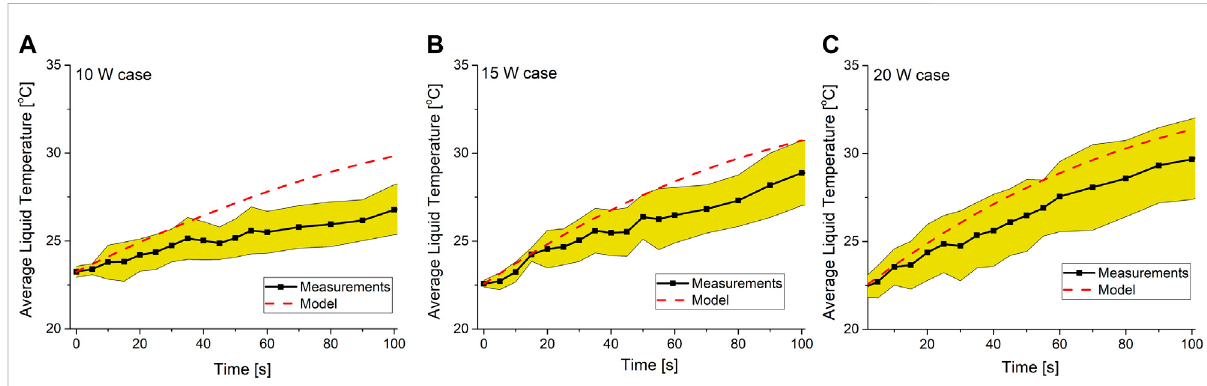
FIGURE 2 Comparison between the computed and measured average liquid temperature as a function of time for operating powers (A) 10 W, (B) 15 W, and (C) 20 W. The solid black line shows the measured average temperature of the liquid, the dashed red line shows the computed average temperature, and the yellow shaded region shows the standard deviation of the experimental